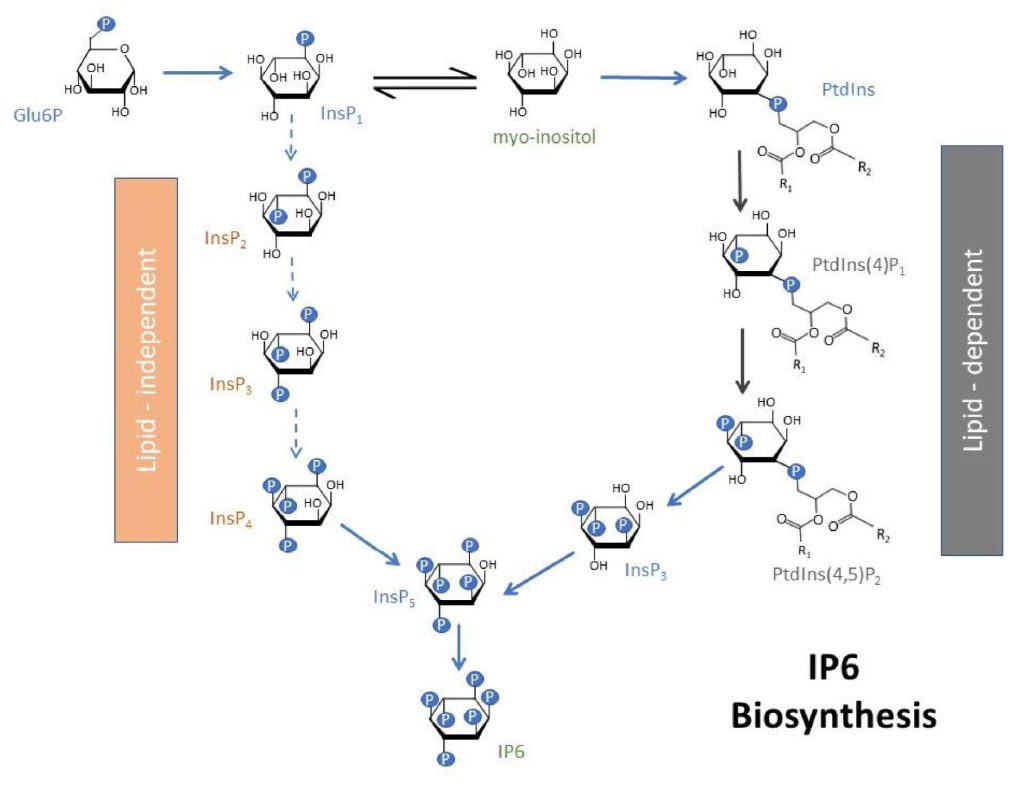
Figure1. Aproposedpathwayforinositolmetabolisminvolvinglipid-dependentandlipid-independent pathways leading to the production of Figure 1. A proposed pathway for inositol metabolism involving lipid-dependent and lipid- independent pathways leading to the production of IP6.